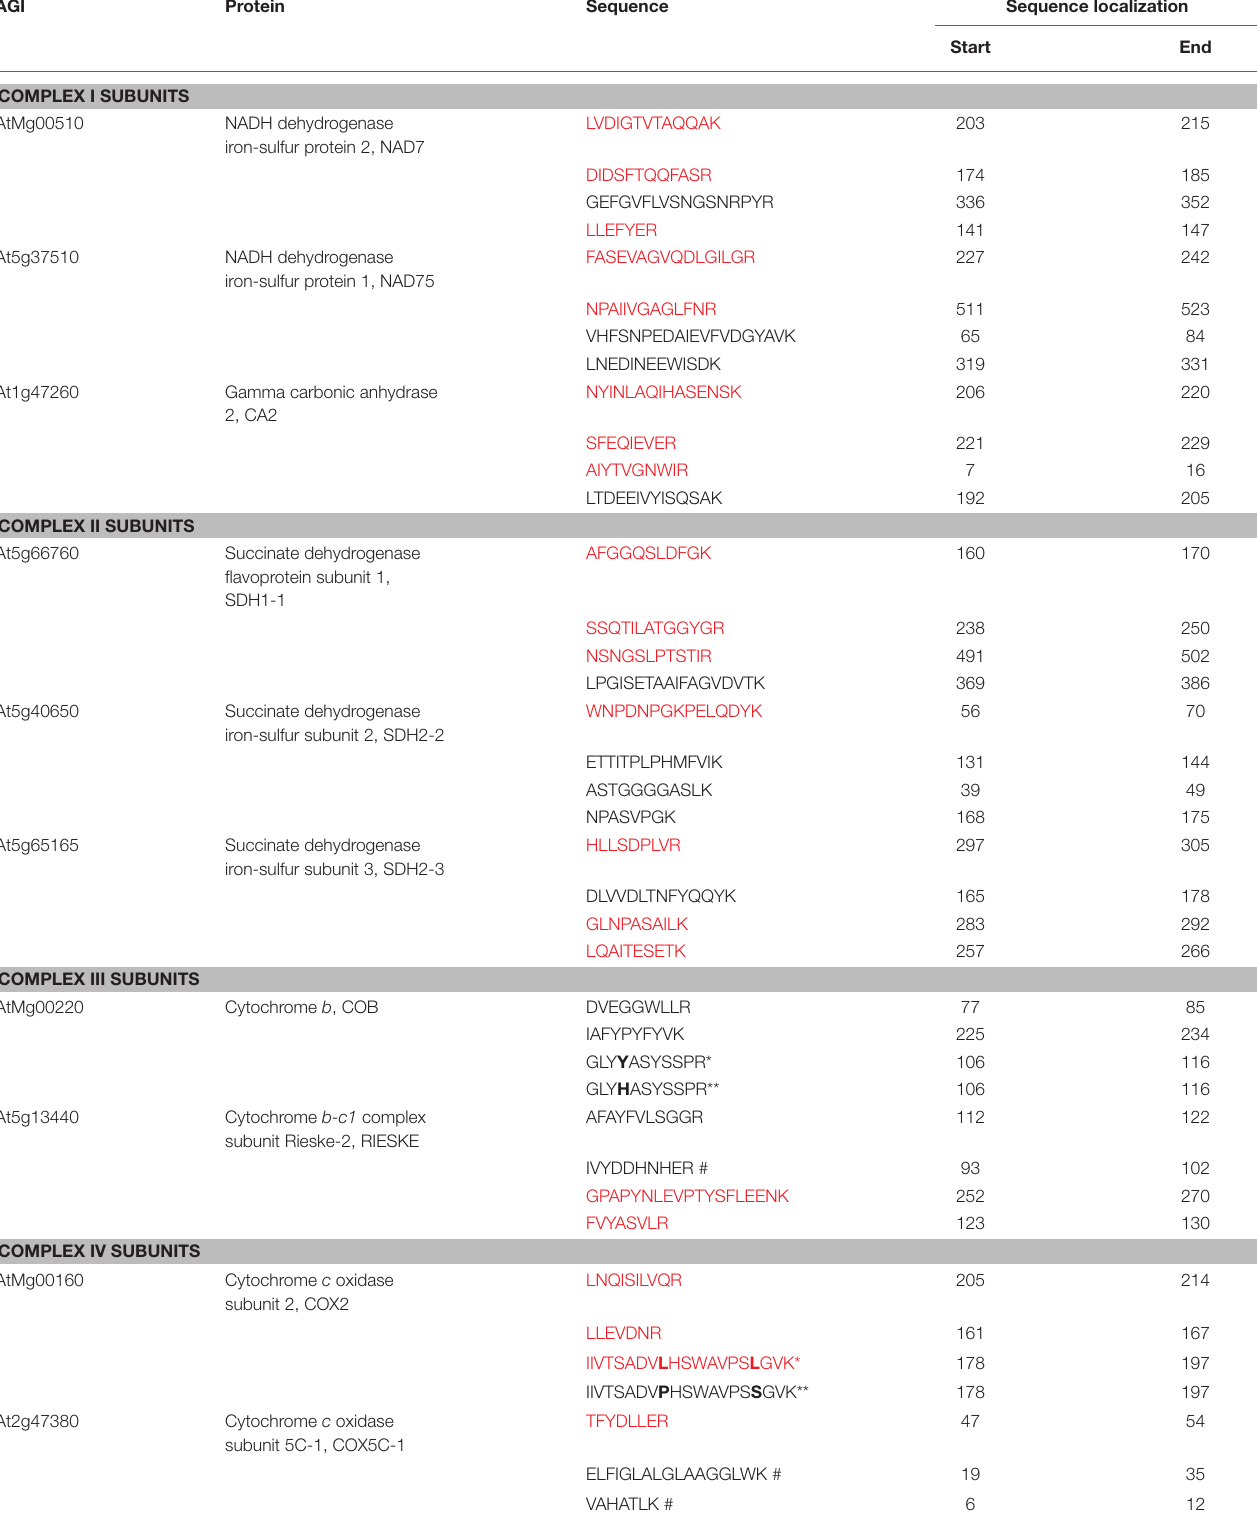
TABLE 1 | Selected mitochondrial proteins and their peptides chosen for MRM analysis using total protein of wild-type and ftsh4 mutant seeds. AGI Protein Sequence Sequence localization